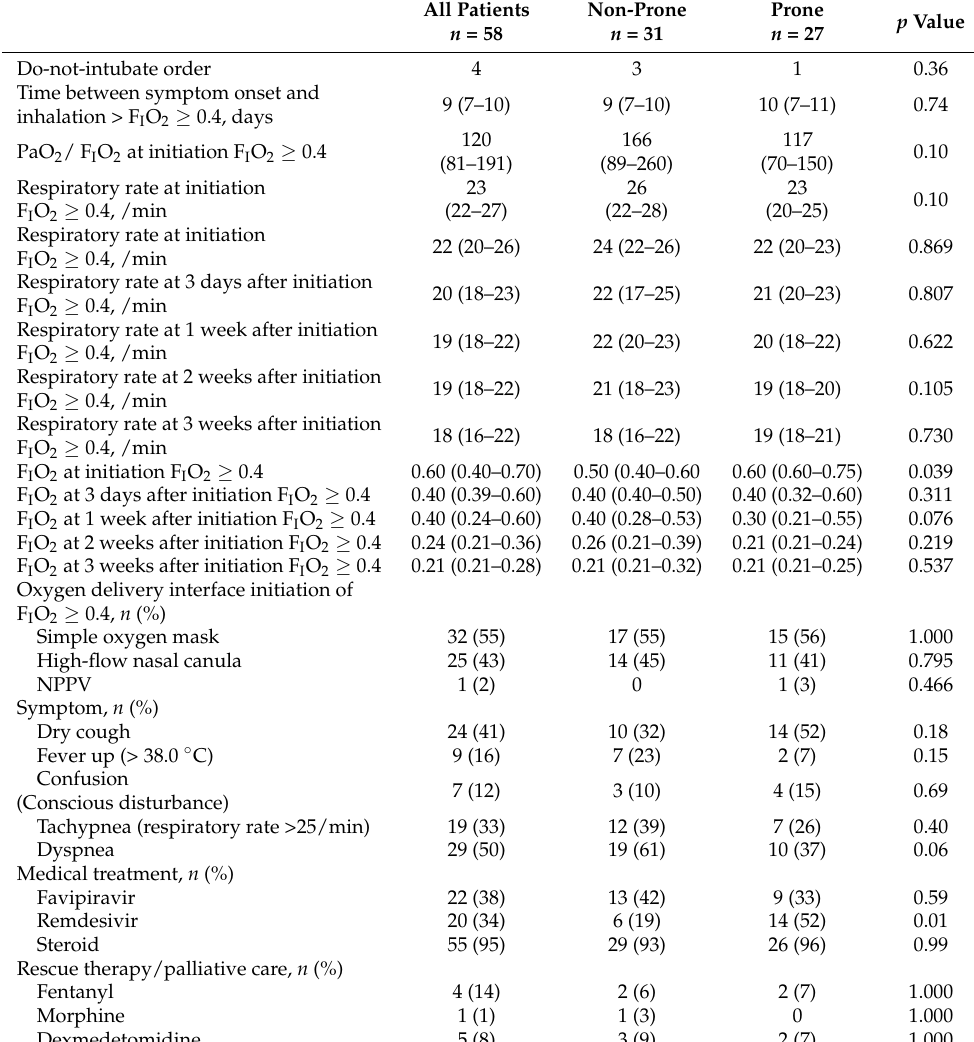
Table 2. Treatment information and respiratory